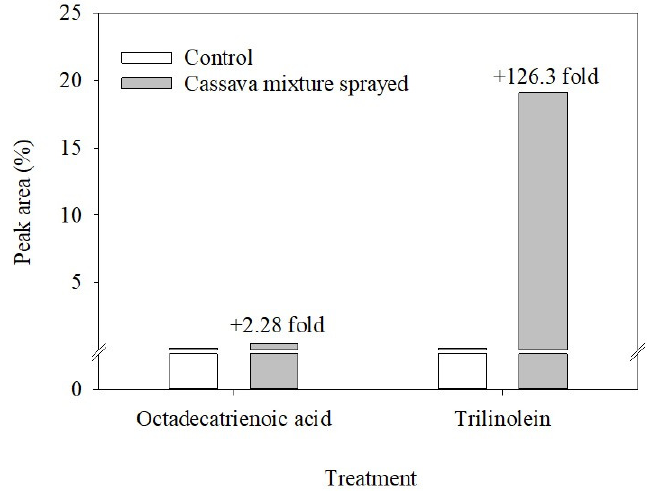
Figure 1. Effect of foliar spray of combined nutrient/biocontrol agent mixture on octadecatrienoic acid and trilinolein relative content in combined nutrient/biocontrol agent mixture sprayed and water sprayed plants. Table 8. Effect of combined nutrient/biocontrol agent mixture spray on tuber yield (kg plant − 1 ), starch (%), and CMD (%) of cassava. Each data point is an average of 20 independent trials con- ducted at different locations ( n = 60). Means followed by the same letter are not statistically signifi- cant at p < 0.05. Traits Treatment Tuber Yield (kg